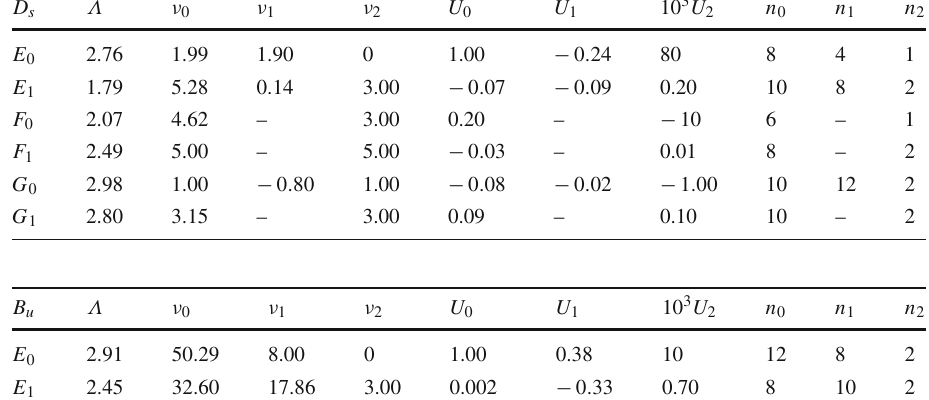
Table 10 Parameters of the BSA representation in Eq. (67) for the B u